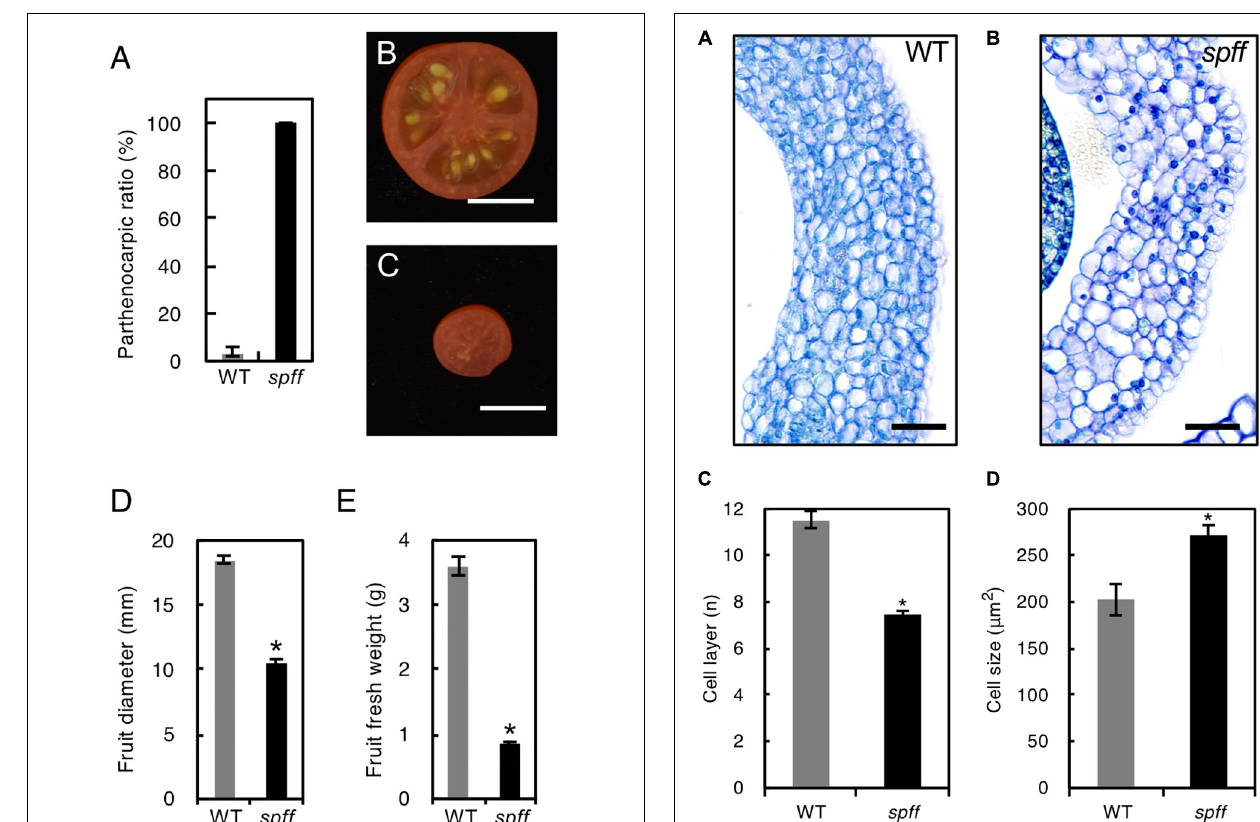
cell layers. This suggested that spff parthenocarpy was associated with cell enlargement, rather than active cell